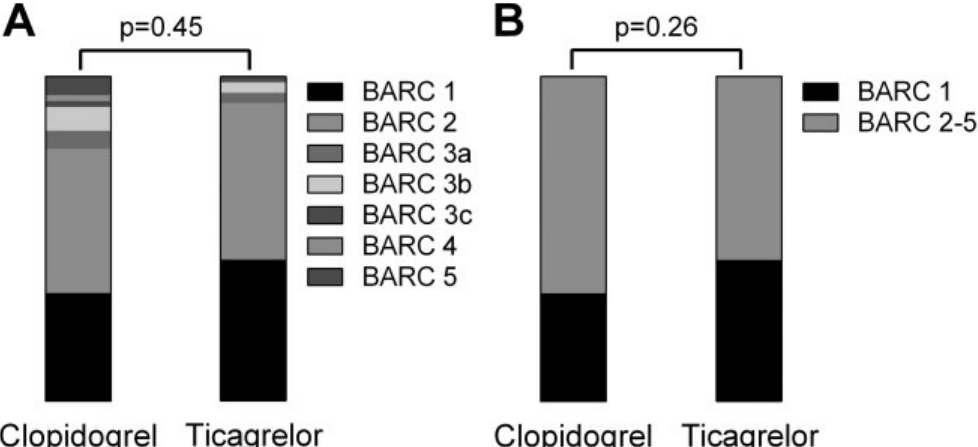
Fig. 1 Distribution of BARC bleeding scores. Distribution of BARC bleeding scores for all BARC subgroups ( A ) and for combined BARC 2 – 5 bleeding ( B ). BARC, Bleeding Academic Research